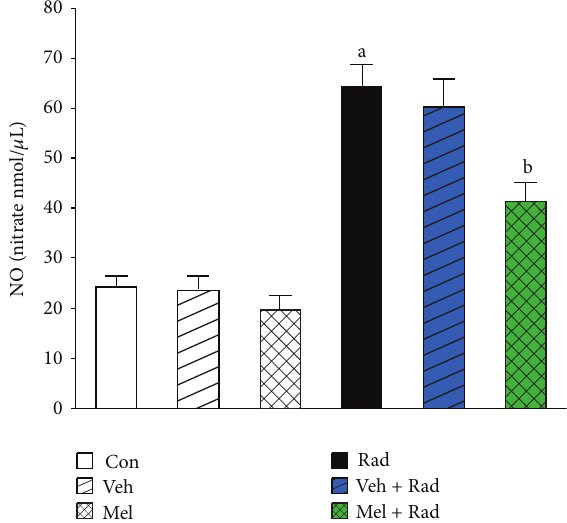
Figure 3: The effect of melatonin on NO levels in rats subjected to whole body gamma irradiation. Data represent mean ± standard error on the mean (SEM) for 5 animals per group. Con: Control group, Veh: Vehicle only group, Mel: Melatonin only group, Rad: Radiation only group, Veh + Rad: Treated with vehicle and exposed to10 Gyradiation,andMel+Rad:Treatedwith100 mg/kgmelatonin before exposure to 10 Gy radiation. a 𝑃 < 0.001 when compared to Control group. b 𝑃 < 0.001 when compared to the radiation only group.